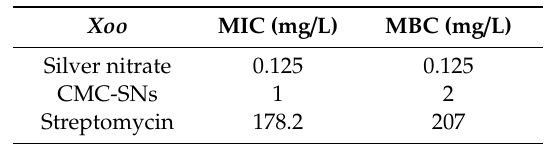
Table 1. MIC (minimum inhibitory concentration) and MBC (minimum bactericidal concentration) of silver nitrate, CMC-SNs and streptomycin against Xoo.